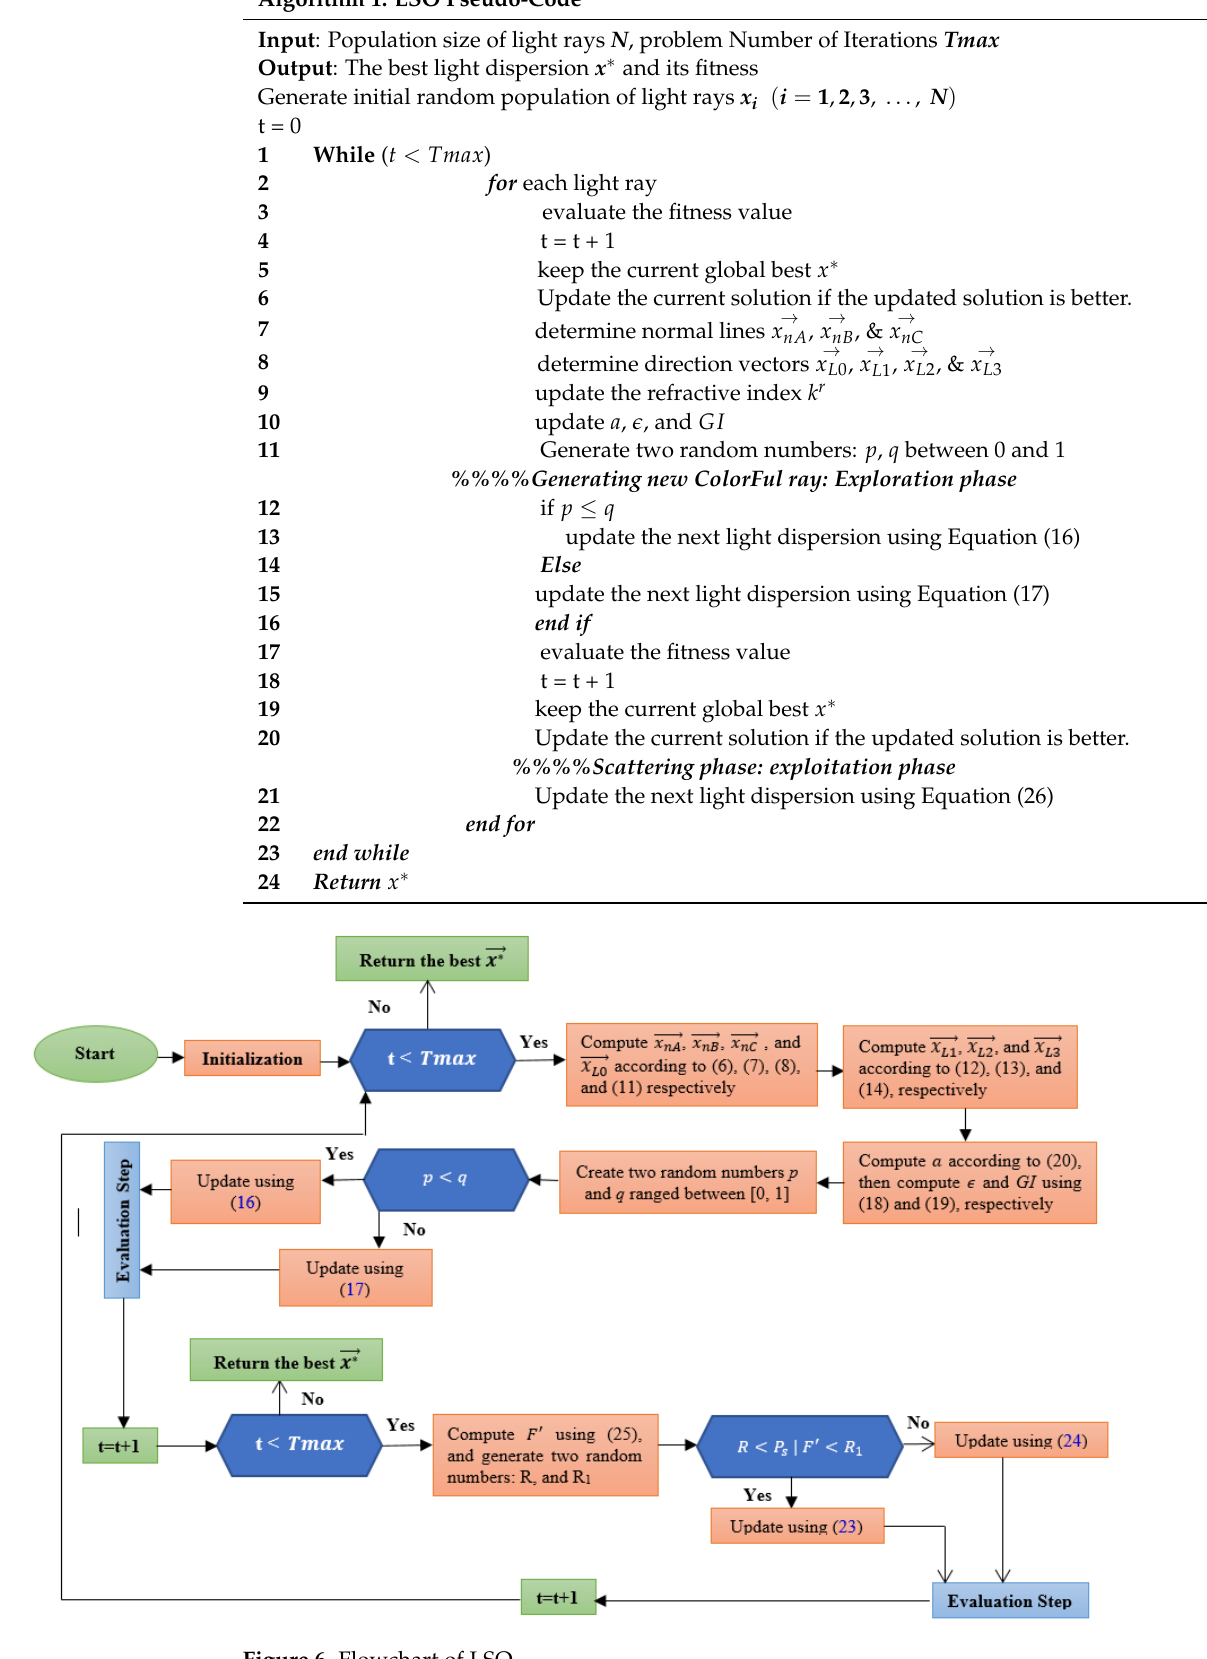
Figure 6. Flowchart of